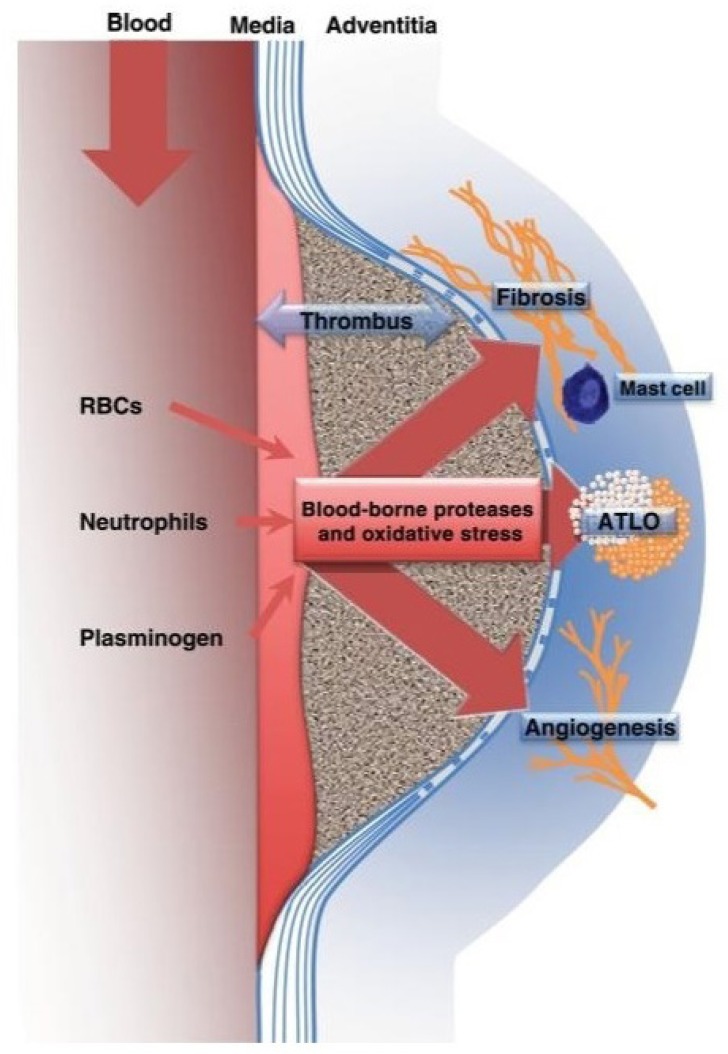
Schematic representation of the impact of the blood-chronic
intraluminal thrombus interface on medial degradation and the
adventitial inflammatory, angiogenic and fibrotic responses in
human AAA. Abbreviations: ATLO, adventitial tertiary lymphoid
organ; and RBCs, red blood cells.